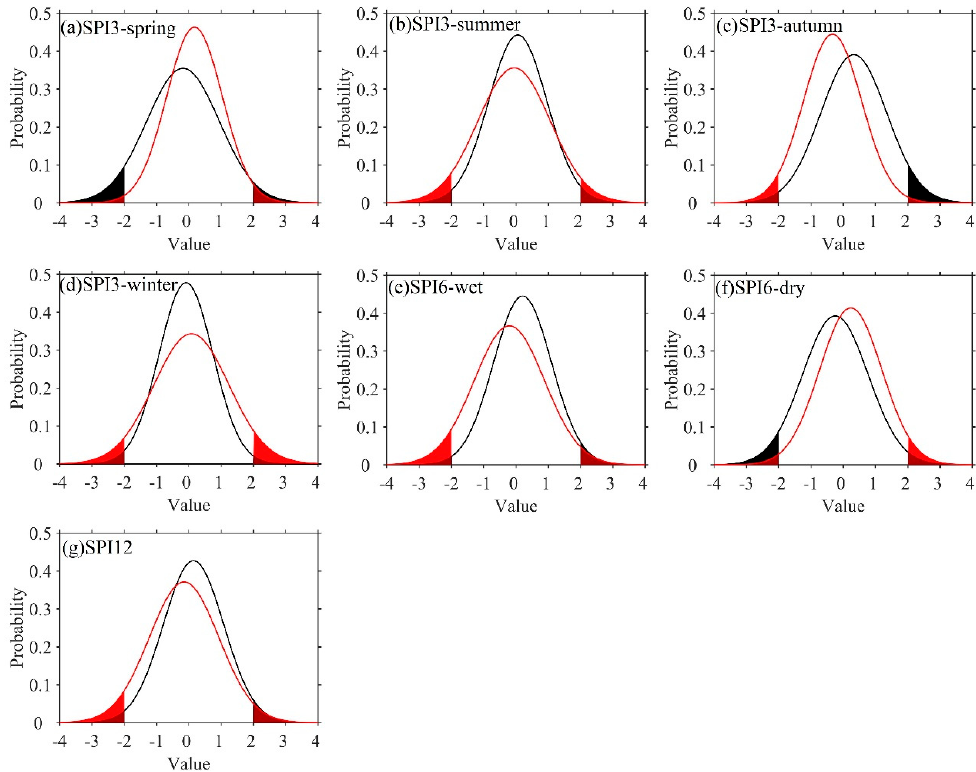
Figure 4. Annual PDFs of regionally averaged SPI in 1961 − 1988 (black line) and 1989 − 2016 (red line), with shaded areas for extreme drought/wet. Table 2. The probability (%) of extreme drought in 1961–1988 and 1989–2016.